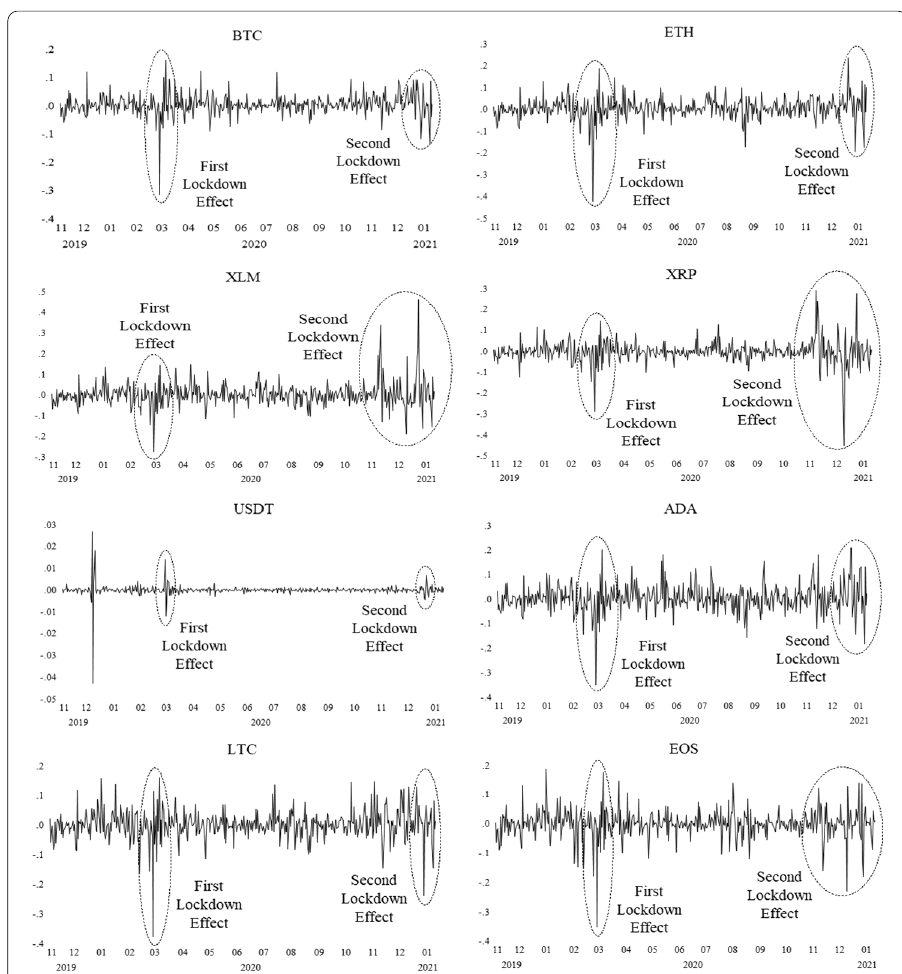
Fig. 2 Dynamics of daily cryptocurrency market returns. Source : CoinDesk, Authors’